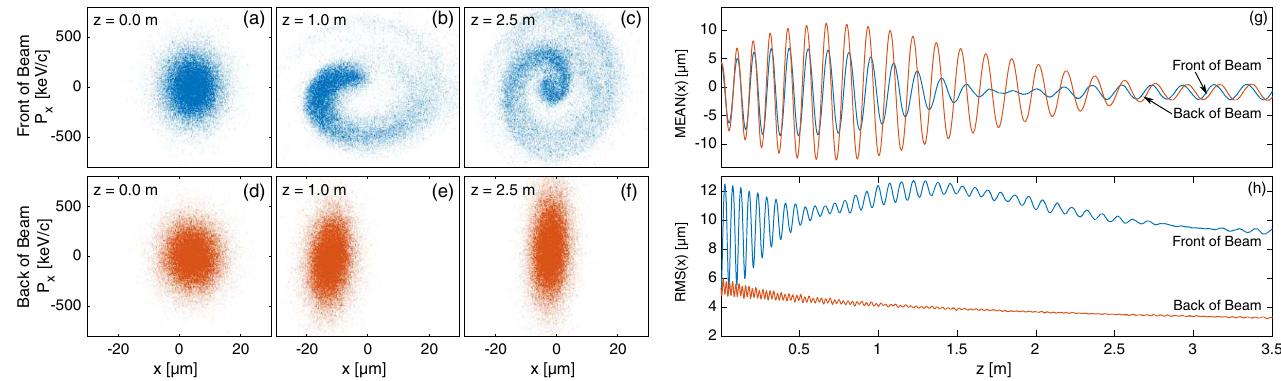
FIG. 6. Plots a to f show the transverse phase space of the offset electron beam at different plasma positions. Plot g shows the macro particle mean position, and plot h their RMS spread. Plots a , b and c , as well as the blue lines in plots g and h represent particles not in the ion column (see Fig. 5), with position 1 . 40 μ m < ξ < 1 . 42 μ m. Plots d , e , and f , and the red lines in plots g and h represent particles in the ion column with position 1 . 55 μ m < ξ < 1 . 57 μ m.